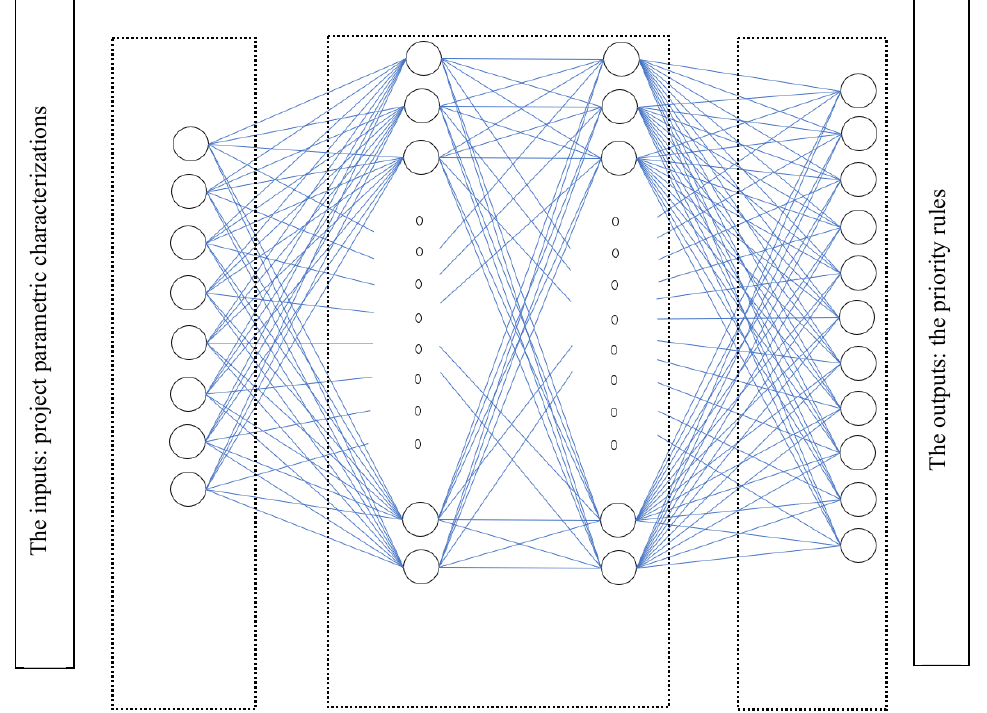
Fig 2. the developed multilayer feedforward neural network (MLFNN) is composed of eight inputs, two hidden layers and the